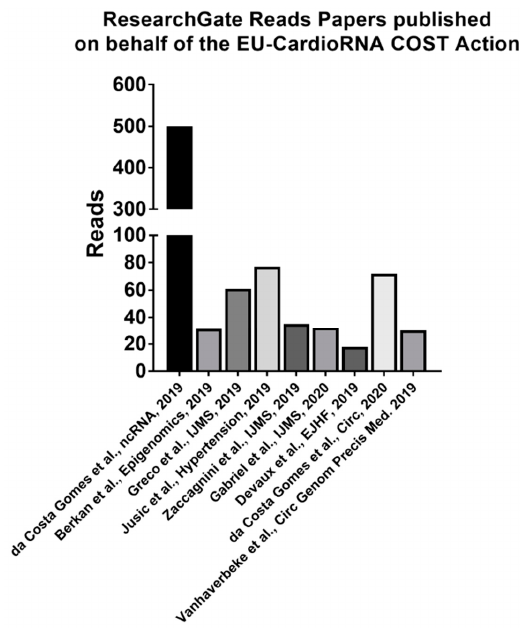
Figure4. Figure 4. Running count of the number of reads for each paper published on behalf of the EU-